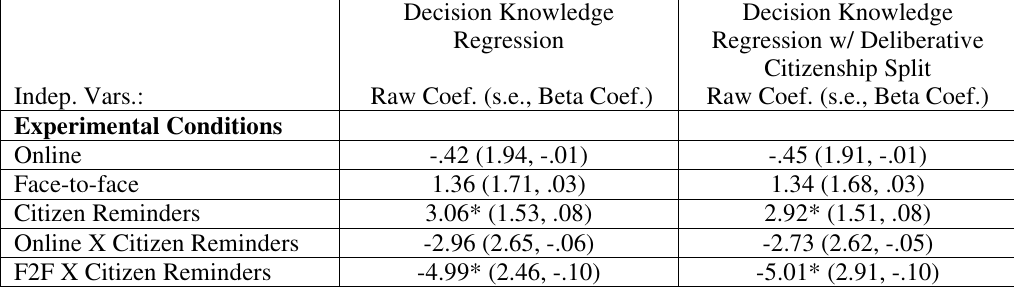
Table 2: Decision Knowledge Regressed on Experimental Conditions, Agency Variables, Political Attitudes, and